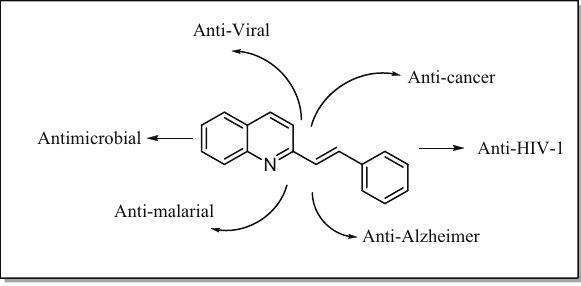
Figure 1: 2 - Styryl quinoline pharmacophore and its pharmacological spectrum [ 8 – 21 ] .